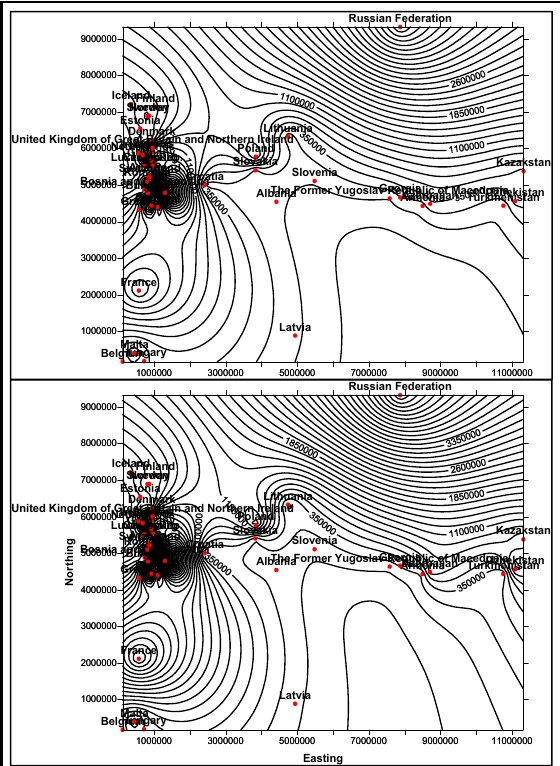
Figure 20. Map view showing diabetes reporting for Europe region for years 2000 and 2003.